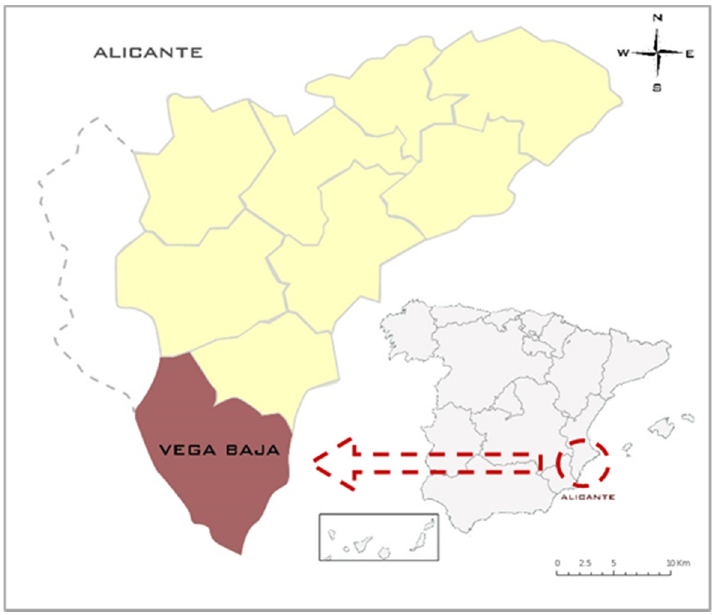
Figure 1. Location of Vega Baja. Own research.